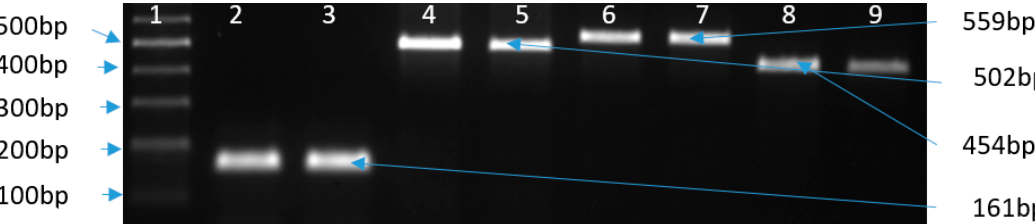
Figure 1. Agarose gel image showing bands of C. jejuni , C. coli , tet (O), and gyr A, where 1: marker; 2: CJ-RS; 3: CJ-CI; 4: CC-RS; 5: CC-CI; 6–7: tet (O) gene (559 bp), and 8–9: gyr A gene (454 bp) from antibiotic-resistant strains (CJ–CI and CC–CI).